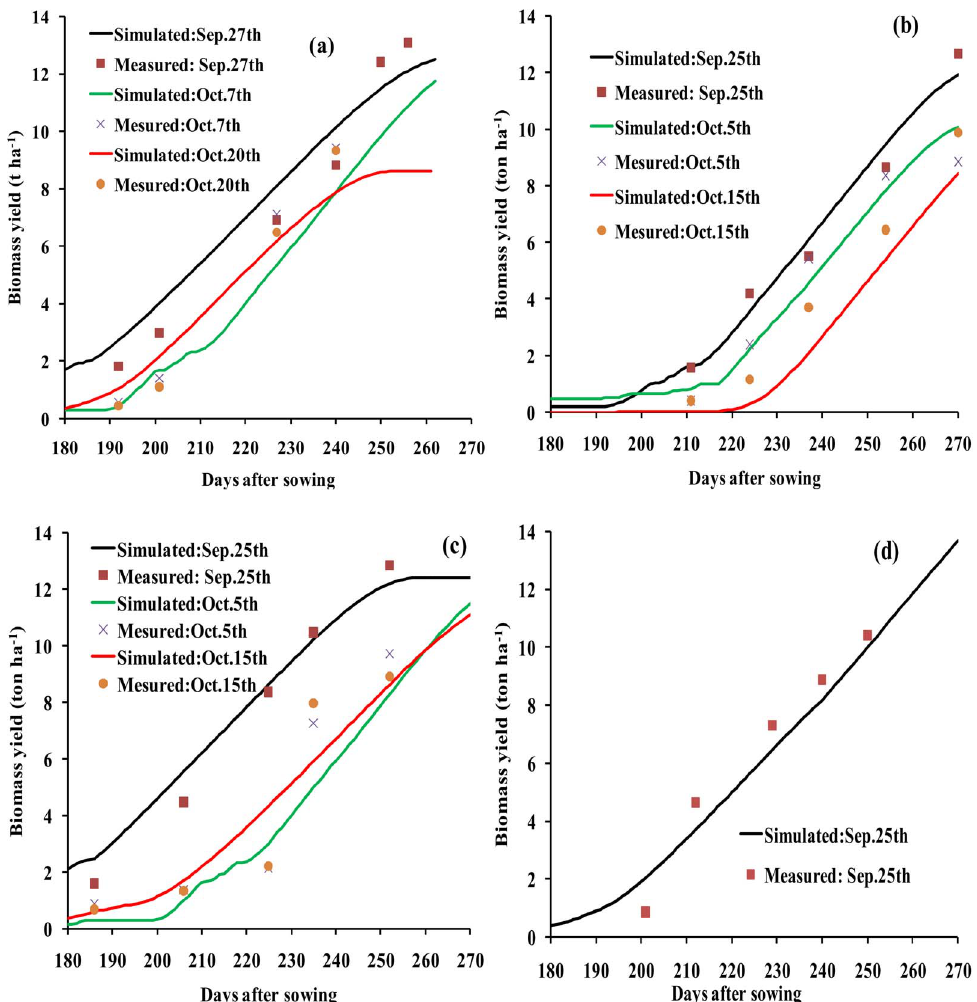
Figure 4. The simulated as compared with the measured aboveground biomass accumulation at different growth stages for winter wheat with different planting dates and irrigation strategies in the cropping season 2008/2009 (a), 2009/2010 (b), 2010/2011 (c) and 201/2012 (d).